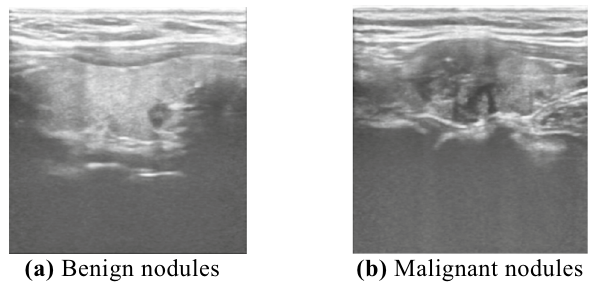
Figure 1. Ultrasonic images of nodules.